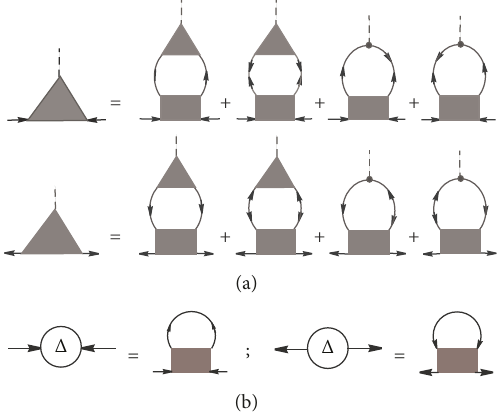
Figure 1: Graphs for the polarization tensor.